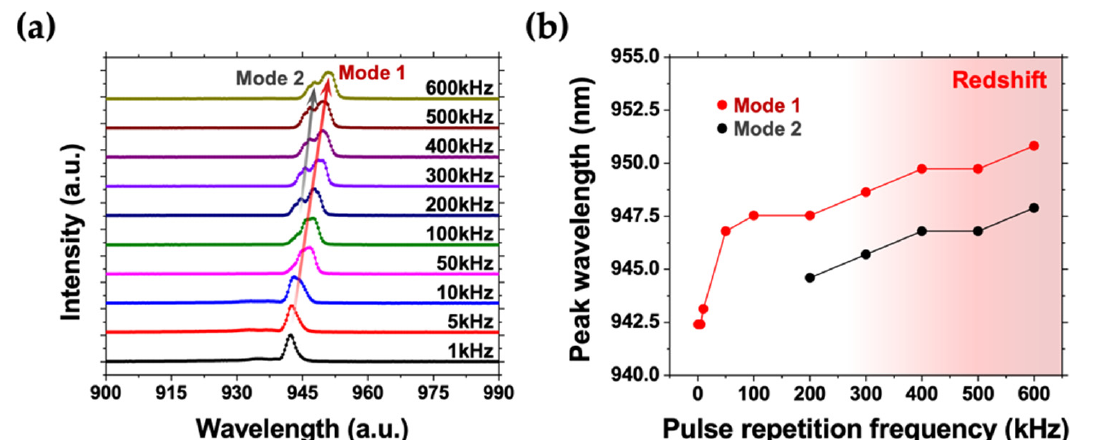
Figure 4. Light emission behaviors of the employed PCSEL operated with a fixed pulse width of 50 ns. ( a ) Light emission spectra of the PCSEL with miscellaneous pulse repetition frequencies. The higher the pulse repetition frequency, the redder the center wavelength of Mode 1. Moreover, starting from 200 kHz, an additional Mode 2 can be distinguished. ( b ) Corresponding center wavelengths extracted from ( a ). While increasing the pulse repetition frequency, the corresponding center wavelengths of Mode 1 shift from 942.4 nm to 950.82 operated at 1 kHz and 600 kHz, respectively. For the additional Mode 2, the corresponding center wavelengths shift from 944.6 nm to 947.9 nm with the pulse repetition frequency of 200 kHz and 600 kHz, respectively.